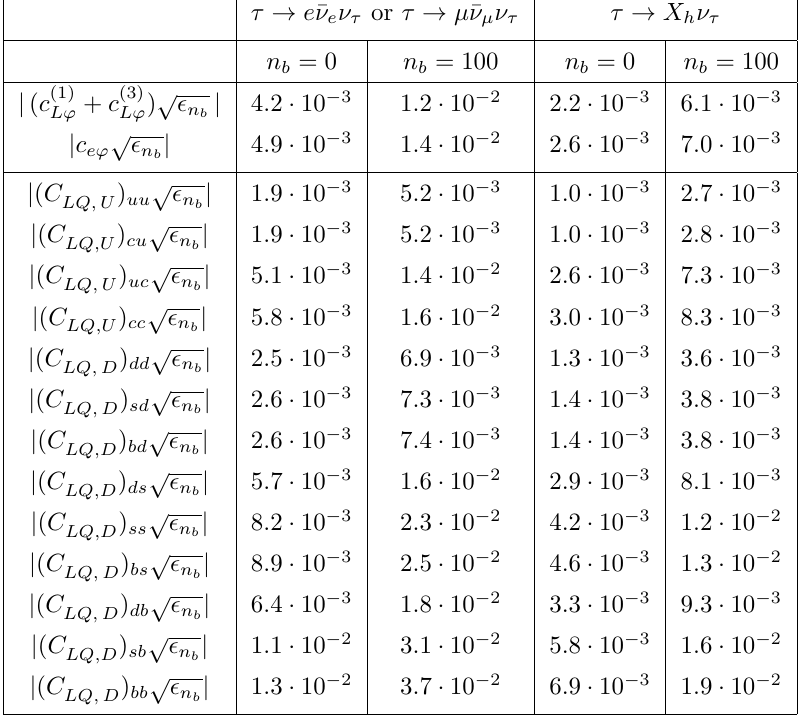
Table 3 . EIC sensitivity to CLFV Z couplings and vector four-fermion operators with left-handed √ quark and leptons, from the τ electronic, muonic and hadronic decay channels. We assume S = 141 GeV and L = 100 fb − 1 . The two sets of 90% CL bounds are obtained assuming that the EIC will observe n = n = 0 and n = n = 100 events. (cid:15) and (cid:15) accounts for the selection cuts that b b 0 100 ensure 0 and 100 background events, respectively, and are functions of the decay channel and of the operator structure. Bounds on the right-handed operators C and C are the same as C eu ed LQ,U and C LQ,D